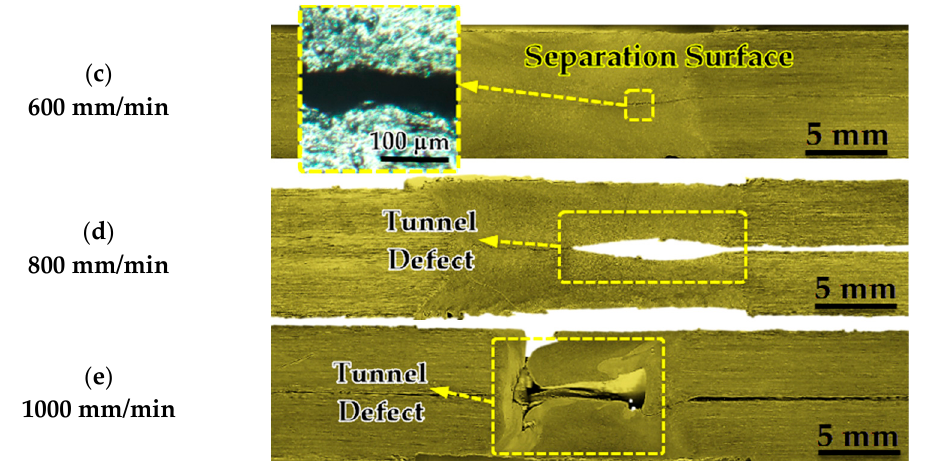
Figure 19. Macrographs of Transverse cross-sections of lap joints produced at 600 rpm rotation speed and different travel speeds of ( a ) 200, ( b ) 400, ( c ) 600, ( d ) 800, and ( e ) 1000 using BT with Tr pin; ( b and c ) separation surface defects; ( d and e ) tunnel defects.